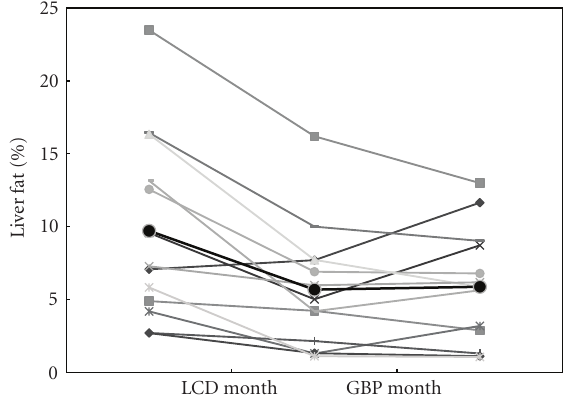
Figure 4: Liver fat concentrations (%) determined using MRS at the three time points ( n = 13). The thicker line illustrates mean liver fat